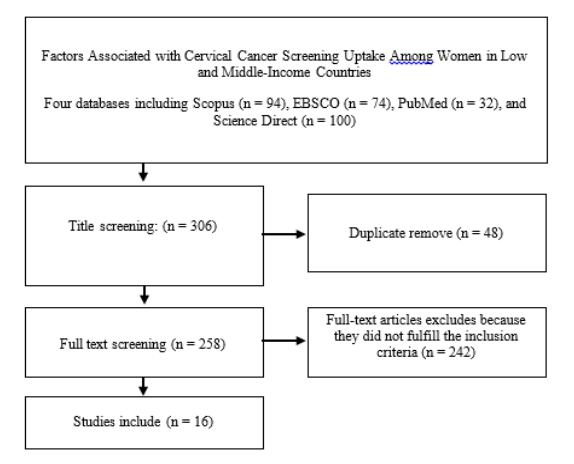
Figure 1. Flowchart of the Articles Selected for the Systematic Review and the Selection Process Using PRISMA (Preferred Reporting Items for Systematic Reviews and